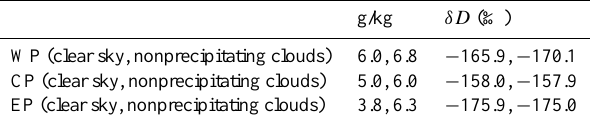
Fig. 6. (a) TES observations of water vapor vs. its isotope for boundary layer clouds (b) TES observations for precipitating clouds. Dashed contour lines represent typical TES observations averaged between 500 and 800hPa. Solid contour lines represent averaged TES measurements of the most sensitive vertical range for boundary layer clouds (400–700hPa) and precipitating clouds (300–600 hPa). 9 10 g/kg δD (‰)